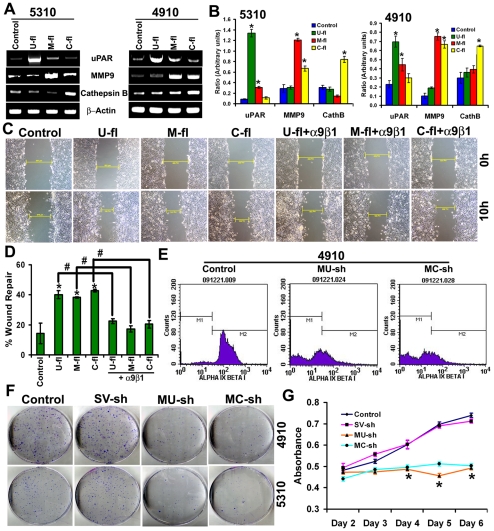
Involvement of α9β1 integrin on the migration potential of xenograft cells and the effect of bicistronic constructs on the glioma xenograft cell proliferation.(A) RT-PCR of 5310 and 4910 cells transfected with uPAR (U-fl), MMP-9 (M-fl), and cathepsin B (C-fl) expressing plasmid DNAs was performed as per standard protocols. Prominent increase in respective mRNA expressions noticed after U-fl, M-fl, and C-fl treatments. Further, quantification of the RT-PCR data (B) revealed significant increases in uPAR mRNA and MMP-9 mRNA expression after treatments with M-fl and C-fl, respectively in both the xenograft cells. (C) Wound healing indicative of increased migration potential noticed after treatments with U-fl, M-fl, and C-fl in 5310 cells was reduced with the same treatments in presence of α9β1 antibody. Photographs are the representative images obtained from three independent experiments. (D) Quantification of wound healing assay. Percent wound repair was calculated from the mean of the average width of the wound obtained from 3 independent experiments. Error bars indicate SEM. *p<0.05 vs. control. #
p<0.05. (E) FACS analysis showing reduced α9β1 integrin levels in 4910 cells after MMP-9/uPAR (MU-sh) and MMP-9/cathepsin B (MC-sh) treatments. (F) Clonogeneic assay depicting the reduced proliferation of 4910 and 5310 cells after MU-sh and MC-sh treatments. After 14 days of incubation, the colonies containing more than 50 cells were counted. Images shown are the representatives obtained from three independent experiments. (G) MTT assay showing significant reduction in the proliferation of 4910 cells from Day 4 to Day 6 after MU-sh and MC-sh treatments. n = 3. *p<0.05 vs. control.